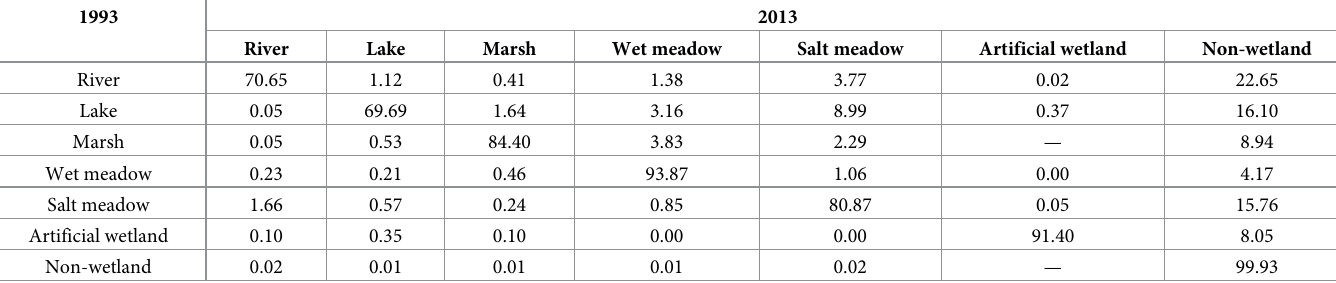
Table 3. Transition matrix of wetlands and non-wetlands in Inner Mongolia during 1993–2013 (in %).